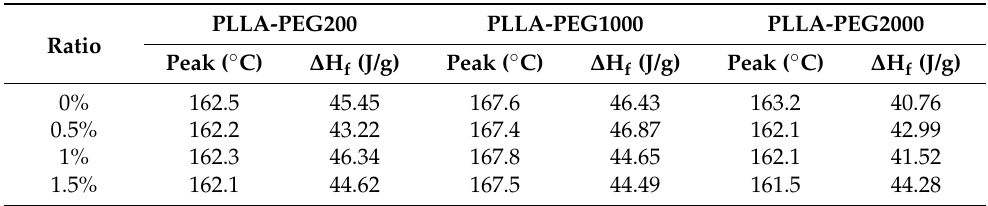
Table 2. The isothermal crystallization peak and ∆ H f list of PLLA-PEG copolymer and nanocompos- ites added different amounts of